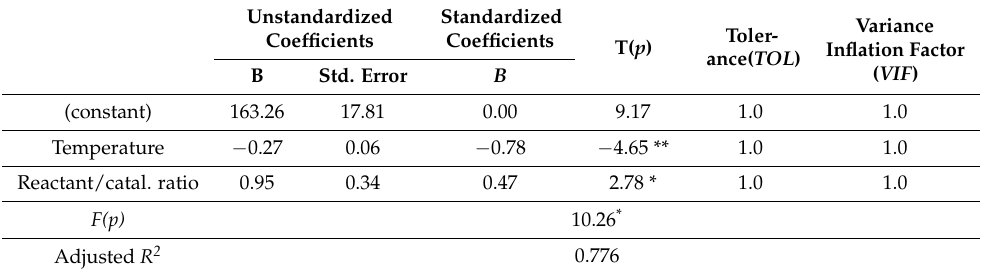
Table 3. Coefficients estimated from multiple regression